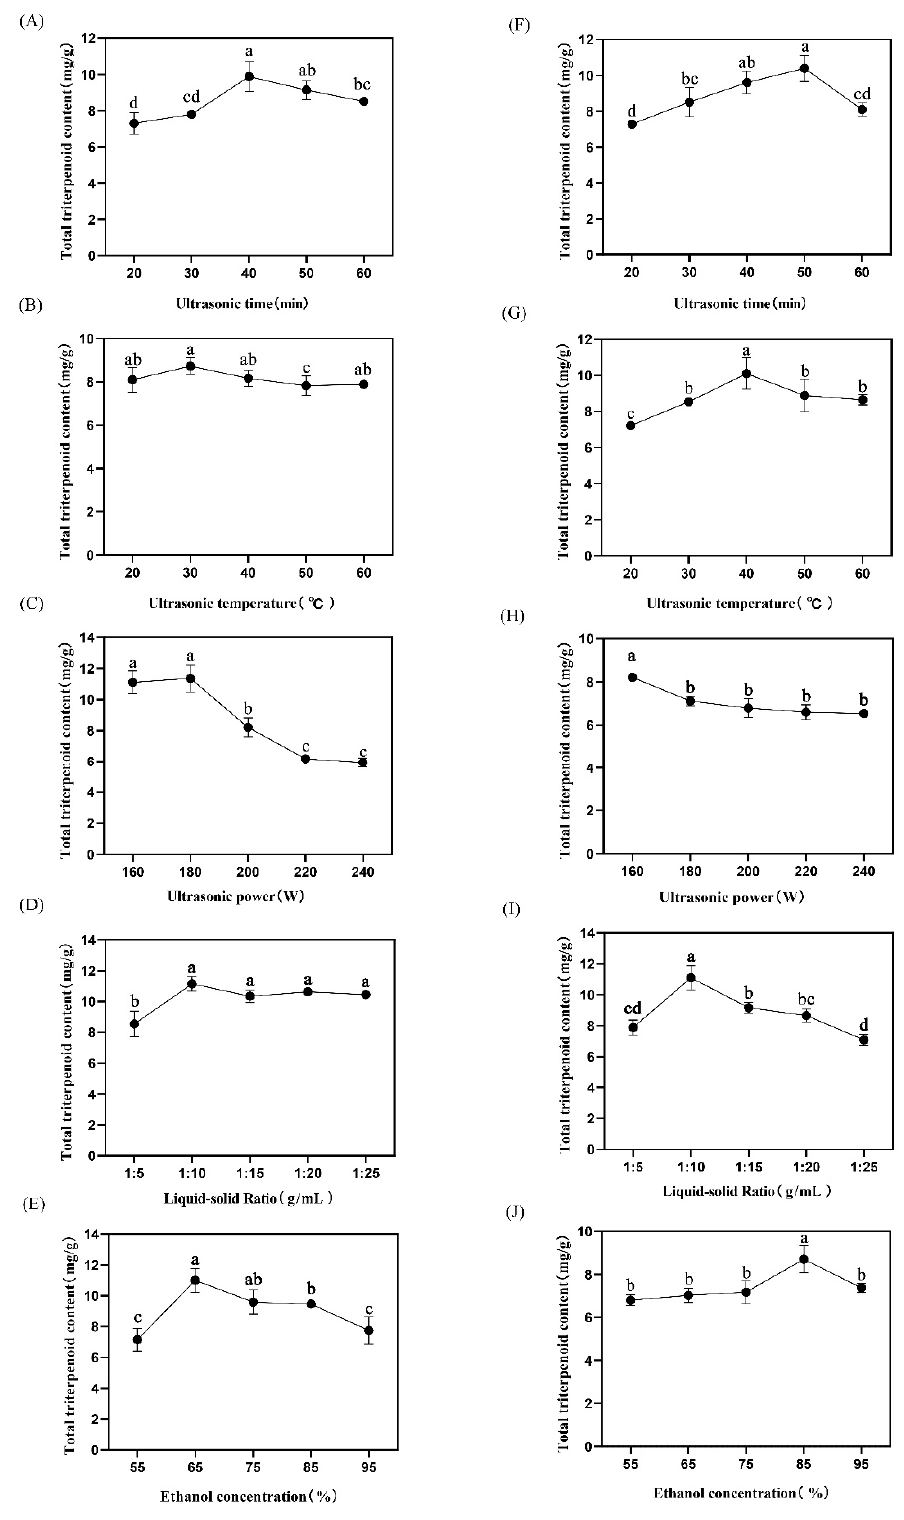
Figure 2. Effects of different factors on extraction of total triterpenes from loquat peel and pulp. ( A – E ): Effects of ultrasonic time, temperature, power, liquid-solid ratio and ethanol concentration on the yield of total triterpenes from loquat peel. ( F – J ): Effects of ultrasonic time, temperature, power, liquid-solid ratio and ethanol concentration on the yield of total triterpenes from loquat pulp. Different lowercase letters indicates significant difference ( p < 0.05).